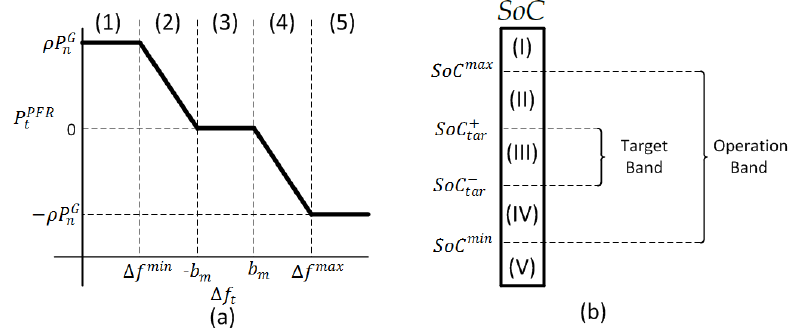
Figure 1. BESS operating regions: ( a ) from the droop characteristic; ( b ) from SoC